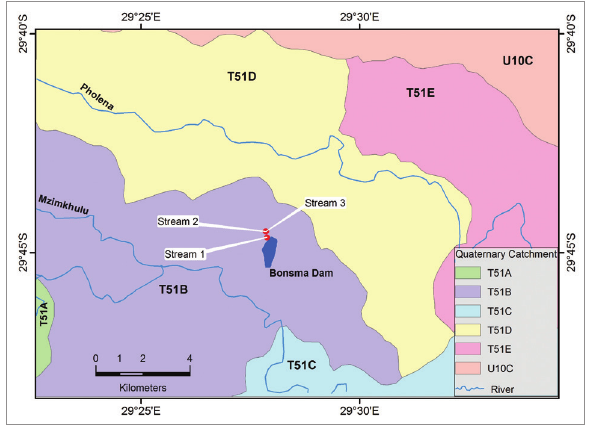
Figure 3: Watershed map showing the three points sampled from inlet streams feeding into the Bonsma Dam. The streams had high nitrate concentrations.